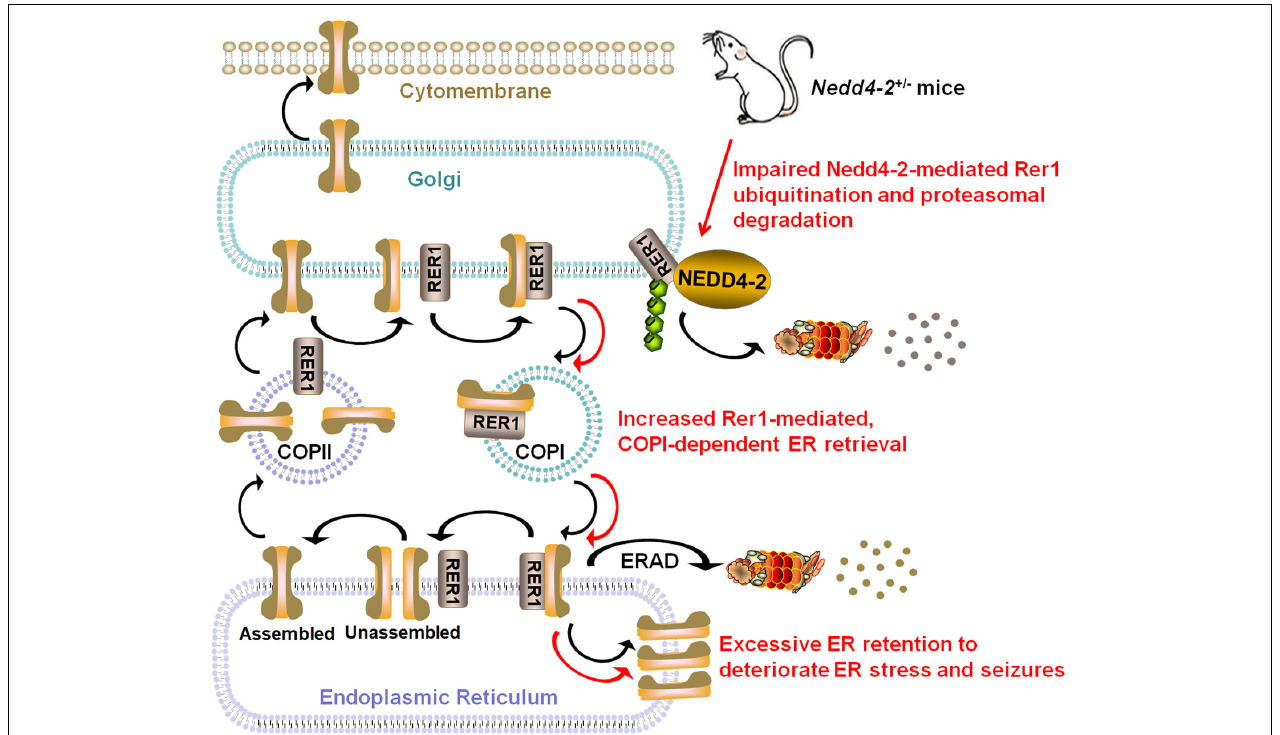
FIGURE 7 | Schematic diagram showing that Nedd4-2 deficiency in mice increases ER stress and seizure susceptibility possibly through impaired ubiquitination of Rer1. The cis- Golgi localized Rer1 retrieves unassembled subunits back to ER for further assembly or ER-associated degradation (ERAD) through a coat protein I (COPI)-dependent pathway. The interactome screening of Rer1 showed potential cargoes that mediate neuroexcitability, among which excessive Rer1-dependent ER retention of the α 1 subunit of the GABA A receptor was found in Nedd4-2 + / −